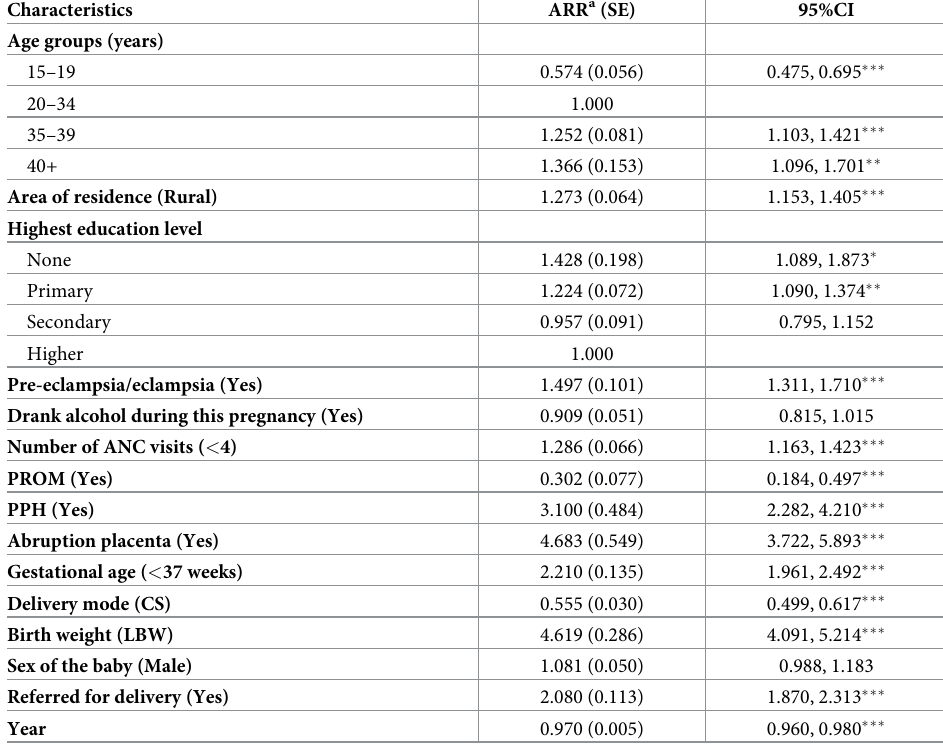
Table 7. Adjusted analysis showing predictors of stillbirth (N = 50,432). Characteristics